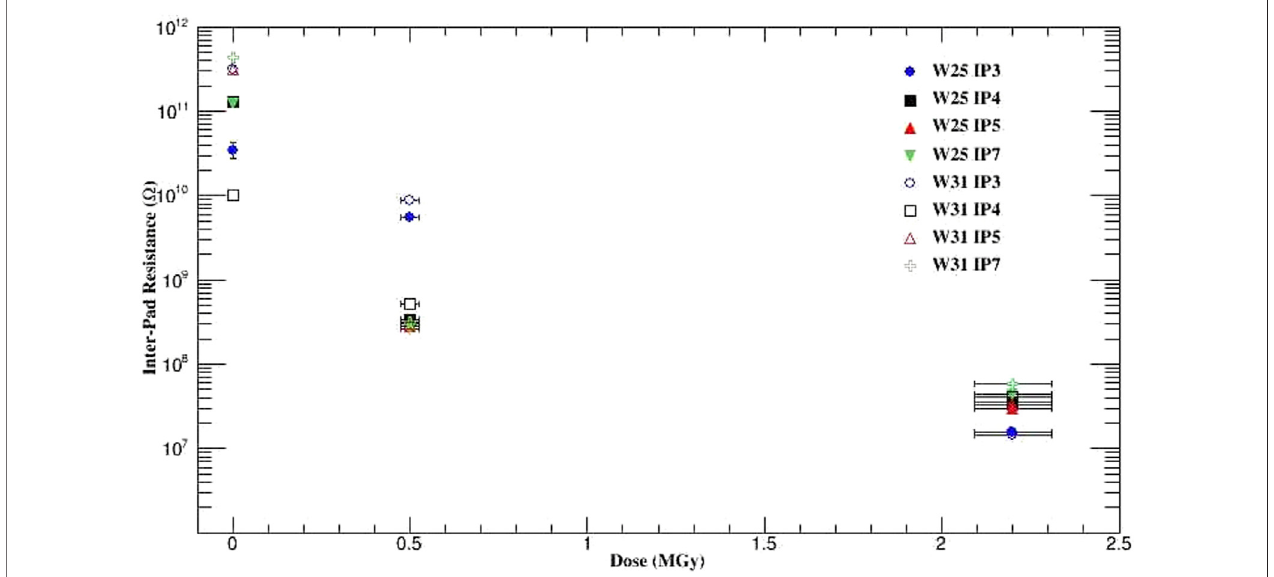
FIGURE 10 | Inter-pad resistance measured on wafers 25 and 31, for all four inter-pad spacings, for doses 0, 0.5, and 2.2